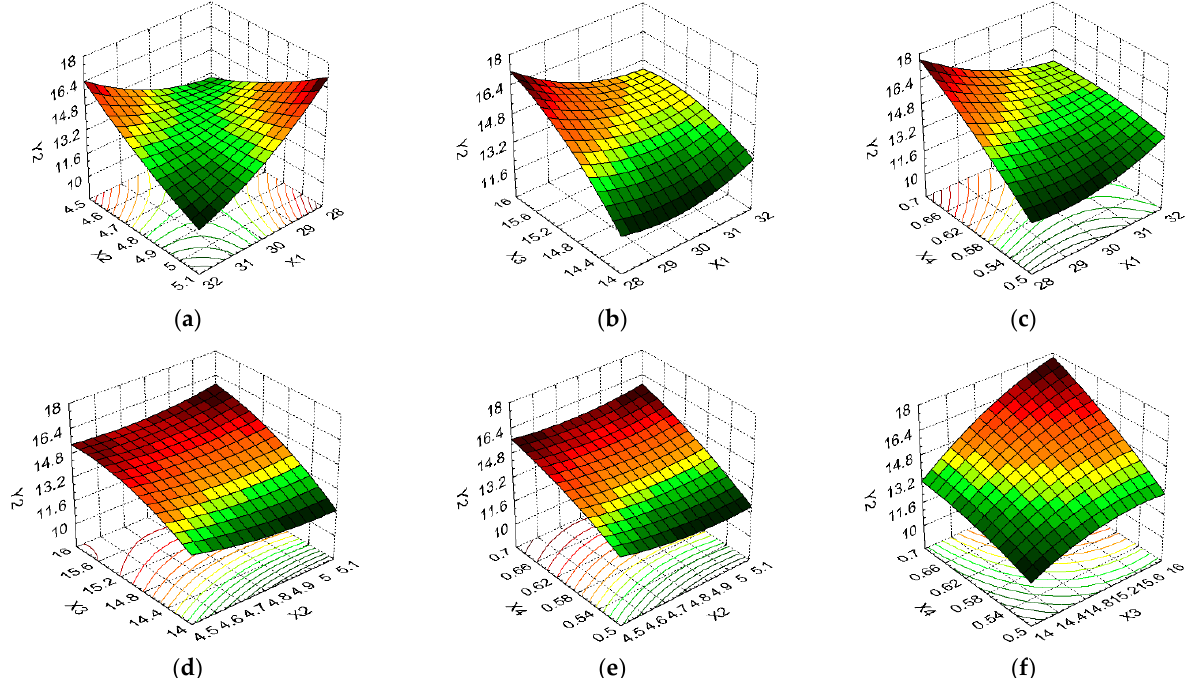
Figure 6. 3D response surface and contour plot showing the effects of different cultivation conditions on the dry biomass response (Y 2 ): ( a ) temperature (X 1 ) and pH (X 2 ); ( b ) temperature (X 1 ) and carbon source (X 3 ); ( c ) temperature (X 1 ) and nitrogen source (X 4 ); ( d ) pH (X 2 ) and carbon source (X 3 ); ( e ) pH (X 2 ) and nitrogen source (X 4 ); and ( f ) carbon source (X 3 ) and nitrogen source (X 4 ).